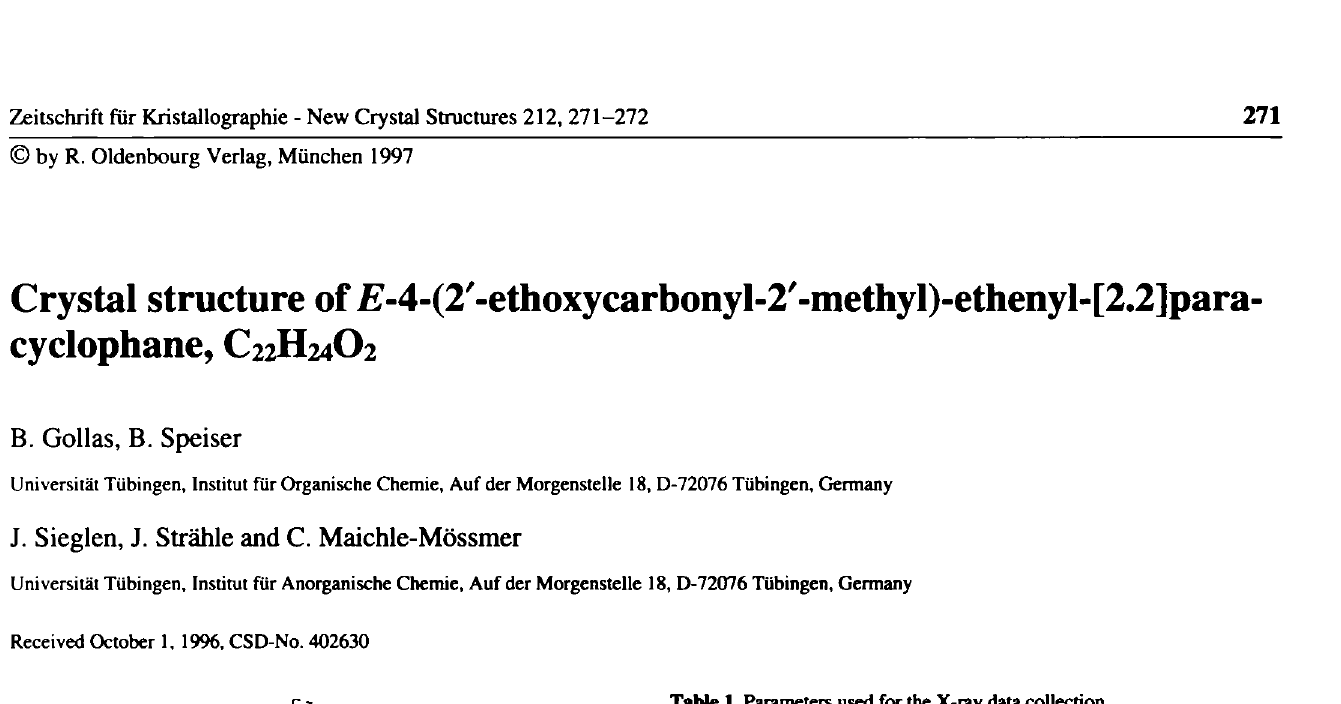
Table 1. Parameters used for the X-ray data collection